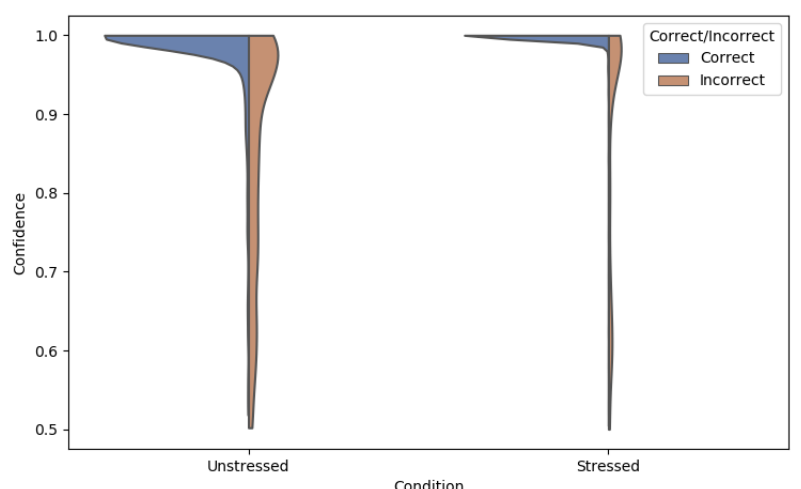
Figure 9. Violin plots showing the difference in distribution in confidence levels between correct and incorrect classifications. This indicates that the model gives far higher confidence scores when it is correct, meaning that it should be possible to set a suitable threshold to remove most misclassifica-